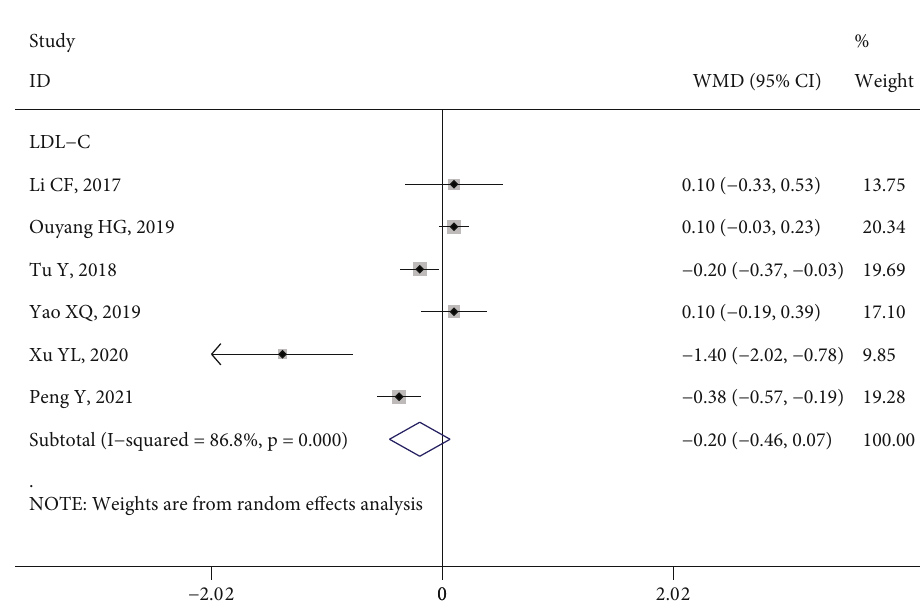
Figure 6: Forest plot of the e ff ect of health literacy intervention on TG.